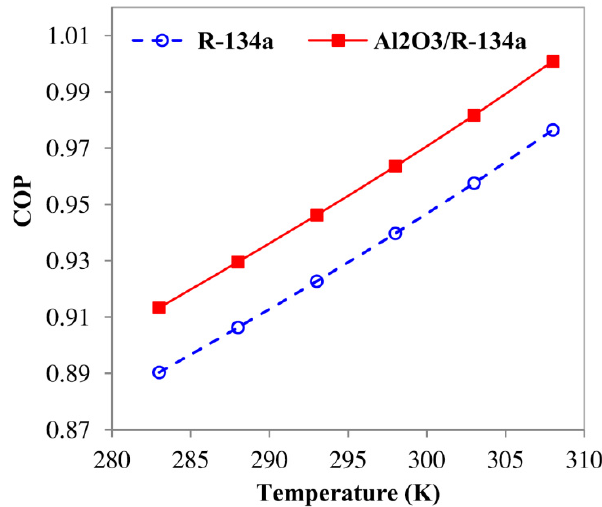
Figure 13. Effect of the specific heat of Al 2 O 3 /R ‐ 134a nanorefrigerant on COP at different temperatures [39]. EMX40CLC and EMU32CLP are hermetic reciprocating compressors with different